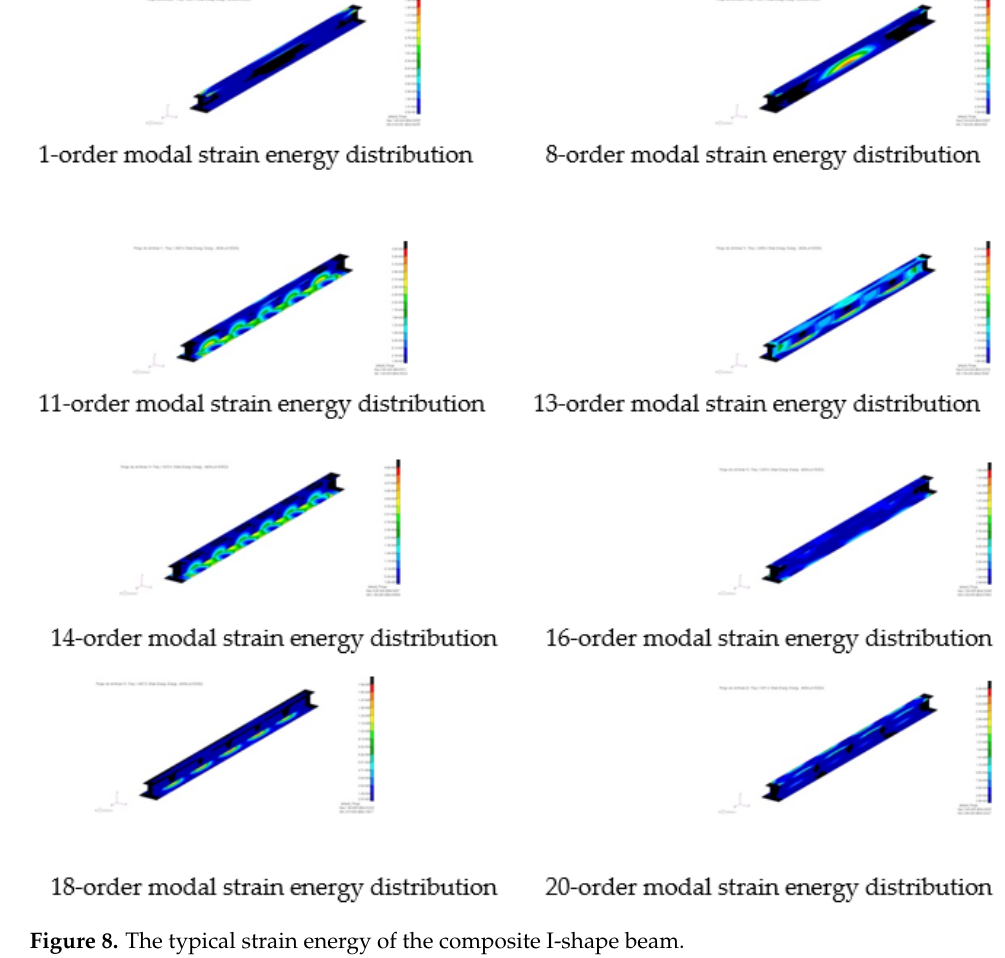
strain energy is indicated in Figure 9.